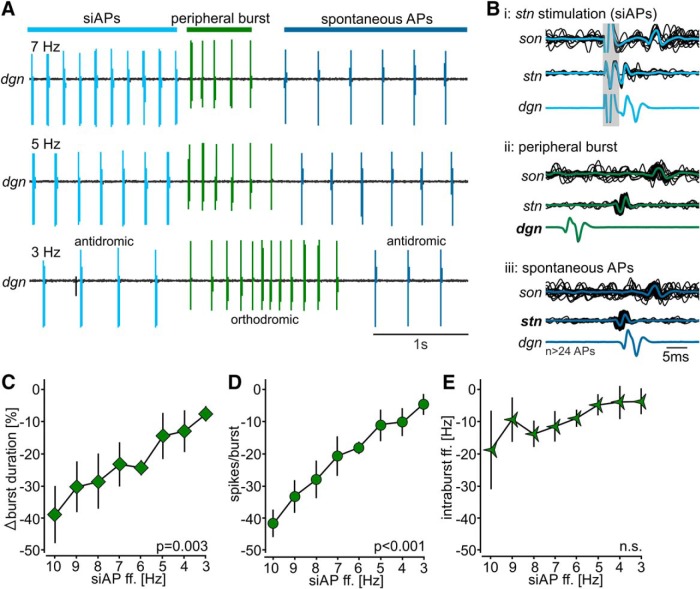
Antidromic ectopic APs alter sensory sensitivity to muscle stretch. A, Original recordings of AGR’s burst activities at different ectopic spike frequencies (7, 5, 3 Hz). Recordings were taken on a section of the dgn. Sensory bursts were elicited by stretching the gm1 muscles. Ectopic APs were elicited with extracellular stimulation of the posterior part of the stn (siAPs) and are highlighted in light blue. Orthodromic APs of the sensory burst are depicted in green while spontaneous ectopic APs are highlighted in dark blue. B, Overlay of several original traces from dgn, stn, and son recordings plus average showing the directions of AP propagation for the three conditions shown in A. The gray area depicts the stimulus artifact. C–E, Quantification of sensory bursts at siAP frequencies between 3 and 10 Hz. C, Burst duration. D, Number of spikes per burst. E, Average intraburst ff. Shown are means ± SEM. N = 8 preparations each.